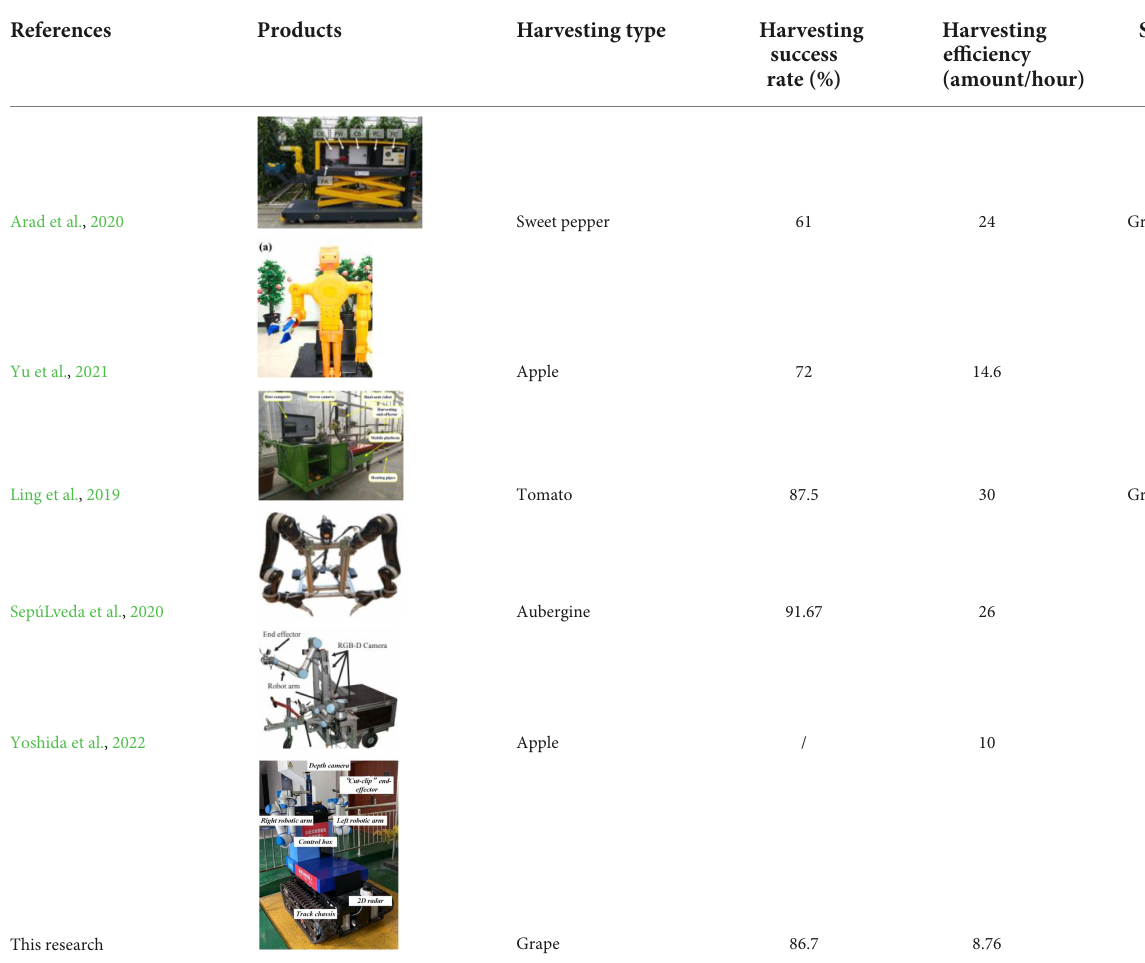
TABLE 4 Comparison between dual arms